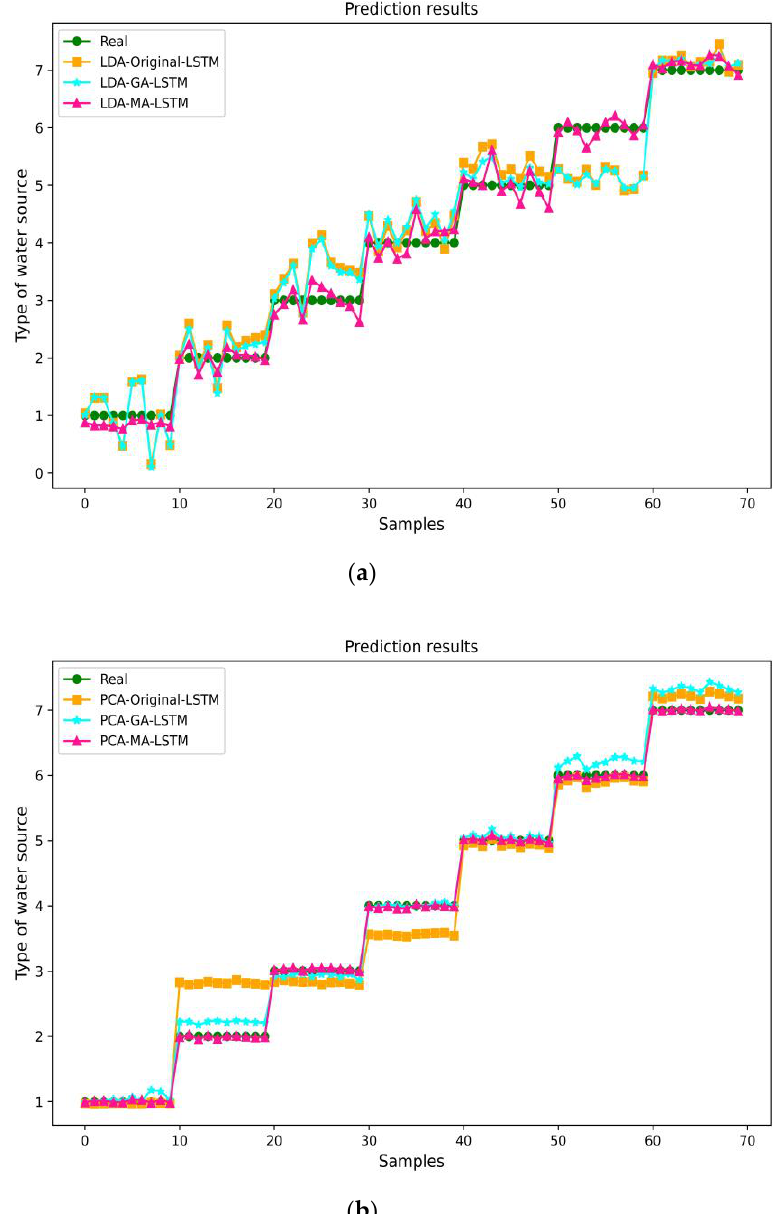
Figure 4. Prediction results for the validation set of different models: ( a ) Prediction results of different models after LDA dimensionality reduction; ( b ) Prediction results of different models after PCA dimensionality reduction.